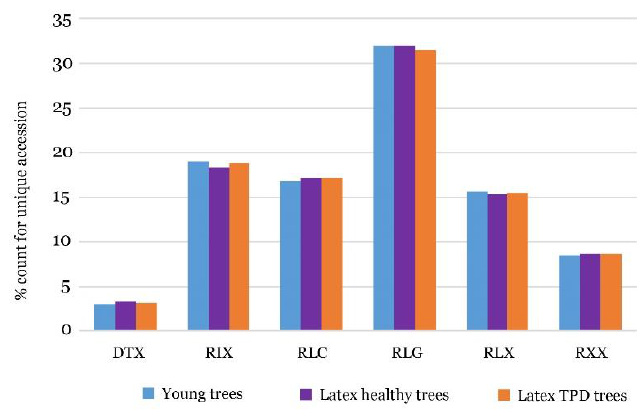
Figure 6. 24-nt siRNA production by transposable element order and superfamilies